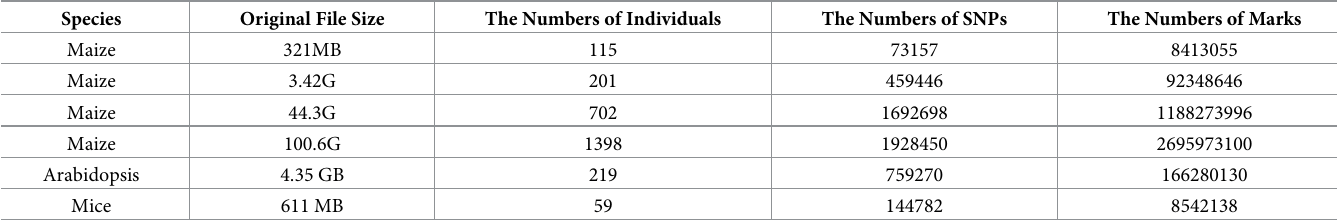
Table 1. The detailed information of data files